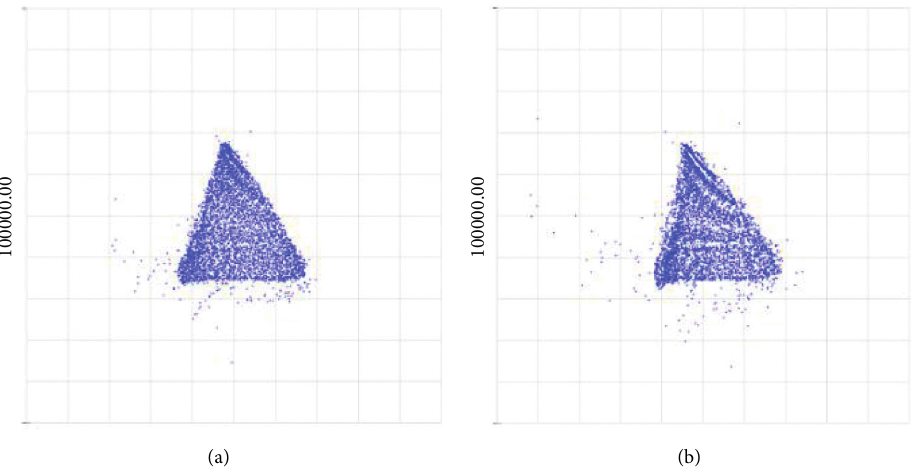
Figure 7: Spot diagrams representing ray distributions beyond D plane: z � 10m (a), z � 100 m